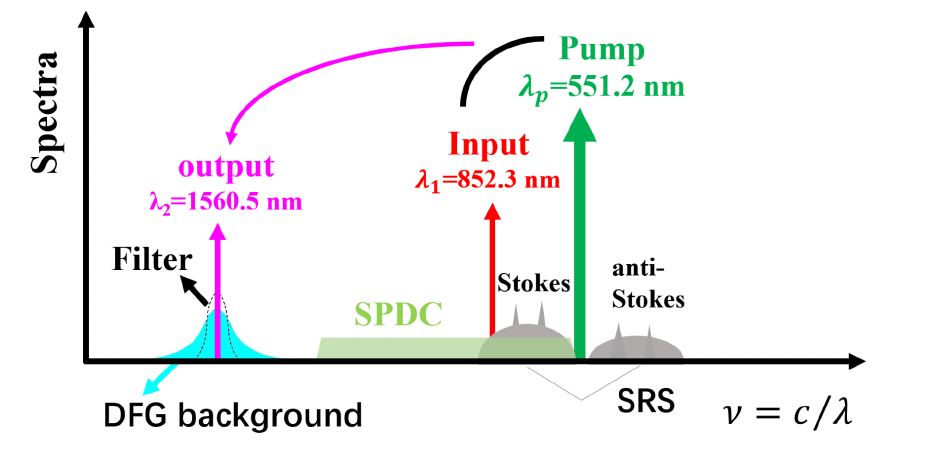
Figure 2. Schematic diagram of the difference frequency generation (DFG) and cascaded DFG. DFG: 852-nm photons near infrared are down converted to 1560-nm photons based on a 551.2-nm pump laser. SPDC, spontaneous parameter down conversion of 551.2-nm pump laser (green area); SRS, spontaneous Raman scattering from 551.2-nm pump laser (Stokes and anti-Stokes photons, gray area); cascaded DFG, differential frequency process between pump laser and noise within the phase-matching bandwidth (blue